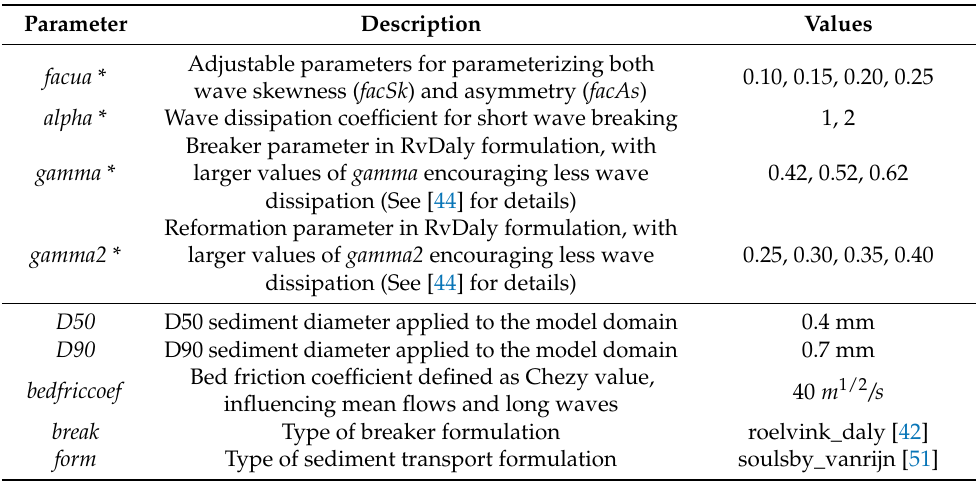
Table 2. Parameter descriptions and values used for calibration